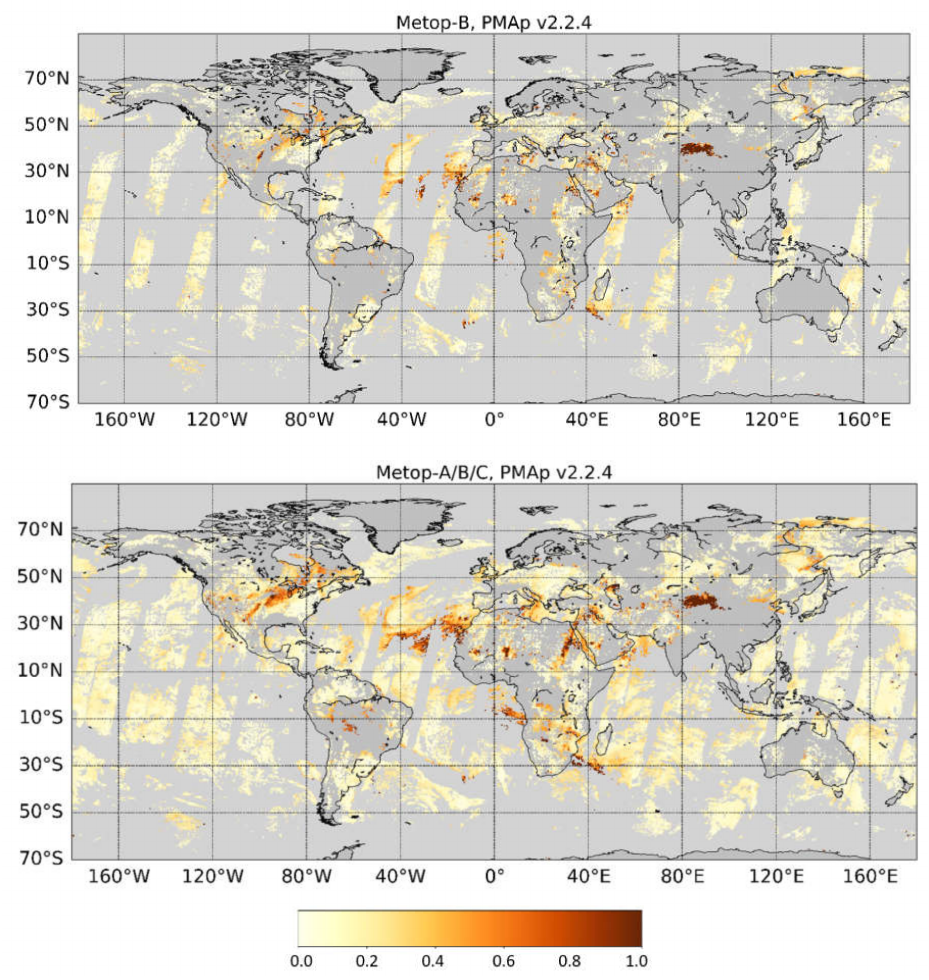
Figure 4. Global daily aerosol optical depth retrieved by PMAp for the 21 September 2020. AOD only based on Metop-B (top) and based on the combination of the three Metops